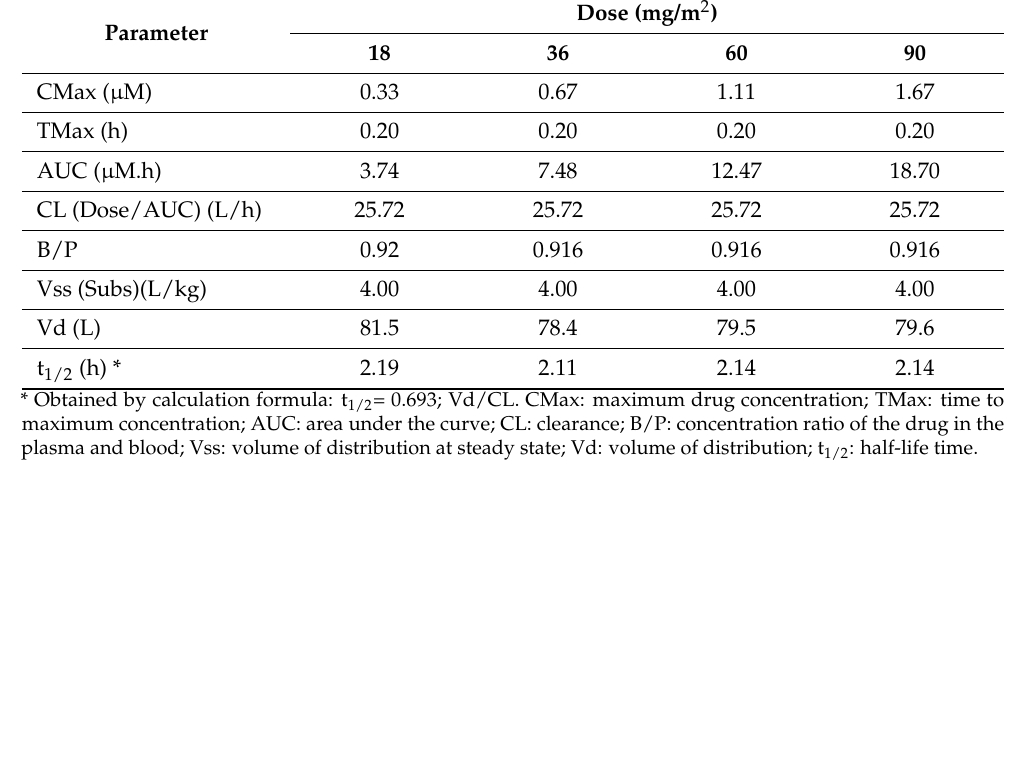
Table 3. LASSBio-1920 pharmacokinetic profiles in human simulation module.